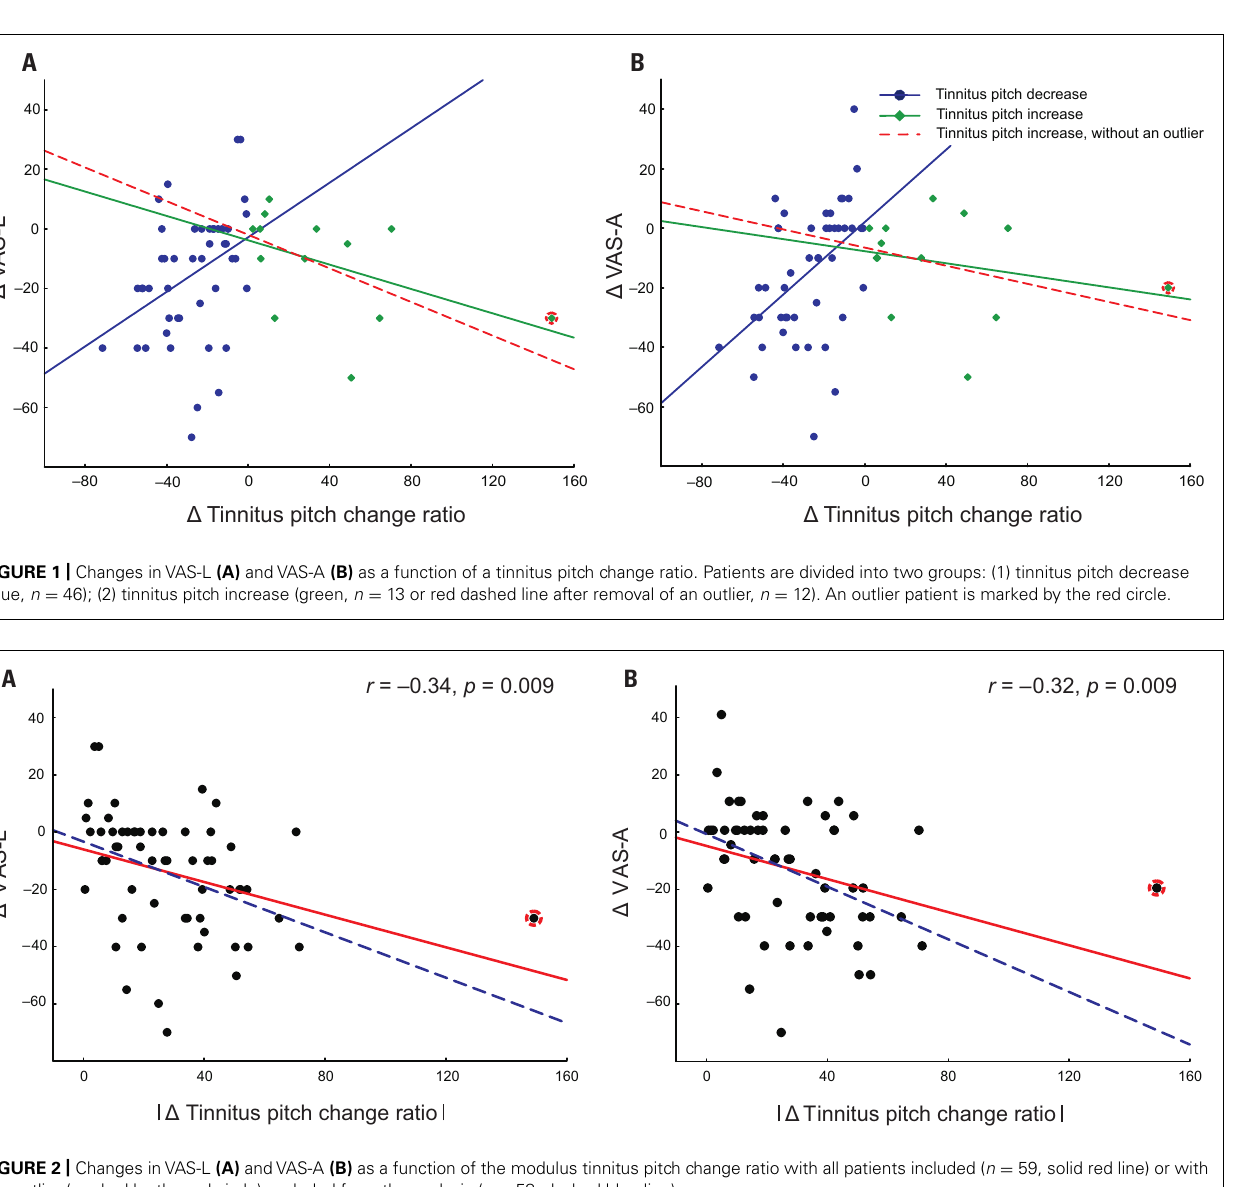
center x − 58, y − 45, z 16; BA 22). Changes in the VAS-A nega- tively correlated with changes in CSD (controlling for the modulus of the tinnitus pitch change ratio, i.e., statistically ruling out the influence of the modulus of the tinnitus pitch change ratio) in the alpha2 band in the right frontal cortex r = − 0.33, p = 0.01 (volumes of interest center x 6, y 37, z 11; BA 24; Figure 4 ). The correlation between modulus of the pitch change ratio and CSD gamma power remained significant ( r = − 0.29, p = 0.03, n = 58) also after removing the outlier from the complete ( n = 59)